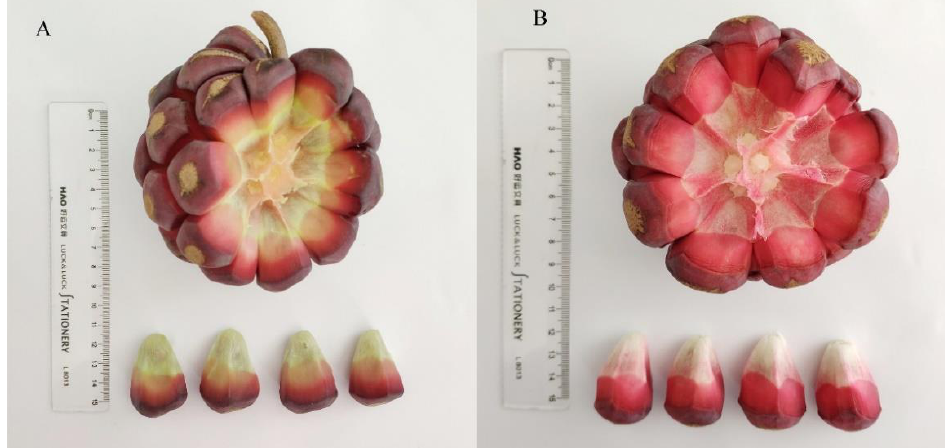
Figure 1. Two kinds of K. Coccinea, Zihe ( A ) and Dahong ( B ).